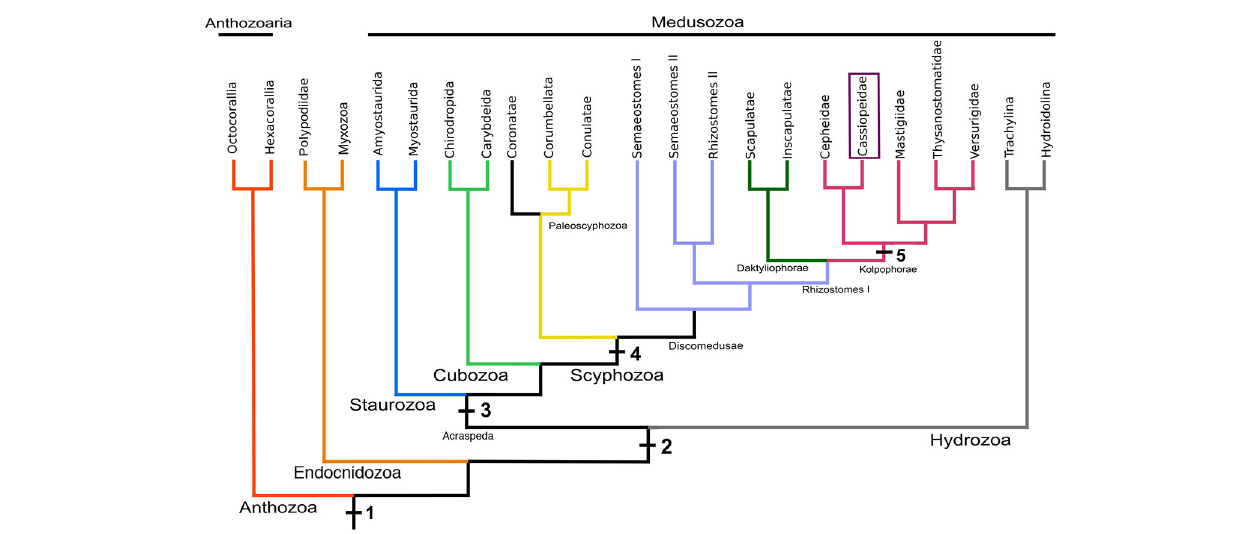
FIGURE 2 | A working hypothesis of Medusozoa phylogeny based on several studies (Bayha et al., 2010; Kayal et al., 2013, 2017), including the monophyletic Scyphozoa, Rhizostomeae, Kolpophorae, and Cassiopeidae. Principal morphological and life cycle characters are plotted on the tree (1, cnidae; 2, medusa stage; 3, rhopalia; 4, strobilation, and ephyra; 5, monodisc strobilation). The topology is not meant to represent a